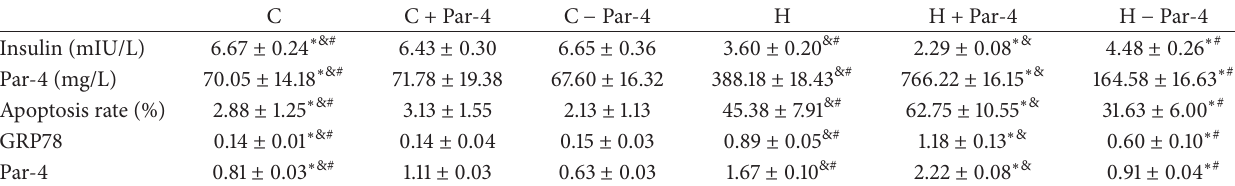
Table 2: The insulin secretion, Par-4 secretion, apoptosis rate, and protein expression of GRP78 and Par-4 of each group. C